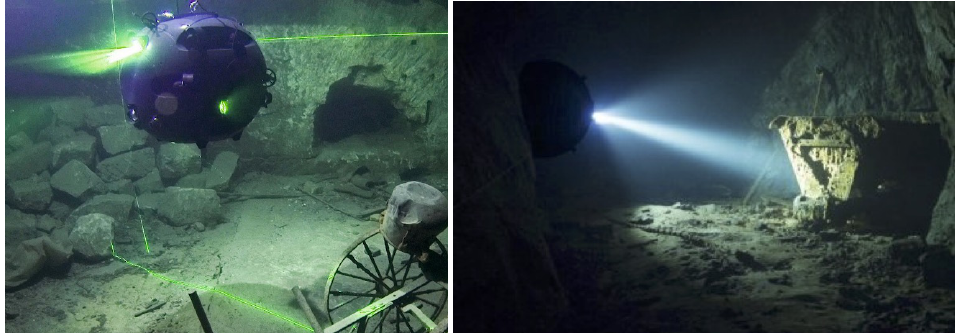
Figure 1. The UX-1 robot and examples of visual landmarks (“OOIs - Object of Interests”) that can be used for robot